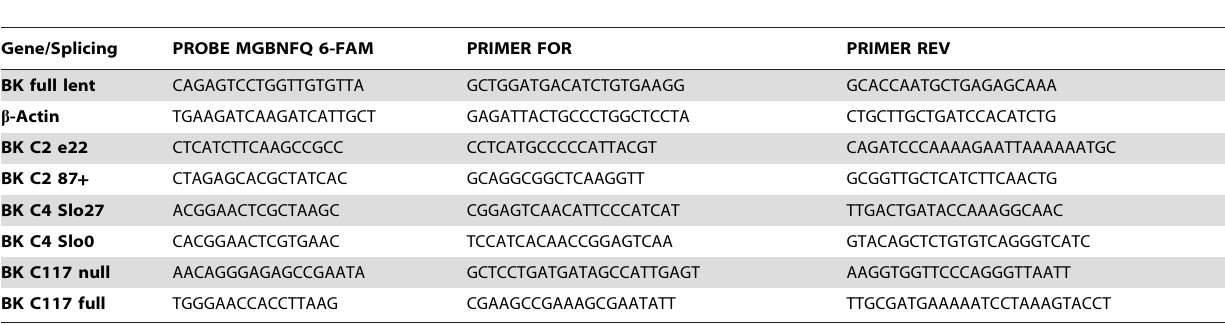
Table 3. Primers and probes used for TaqMan TM quantitative real-time PCR (qRT-PCR)